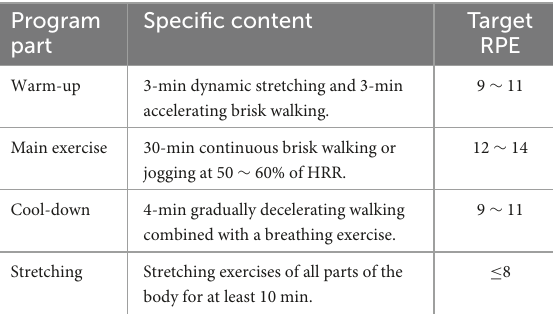
TABLE 1 Stage I aerobic exercise